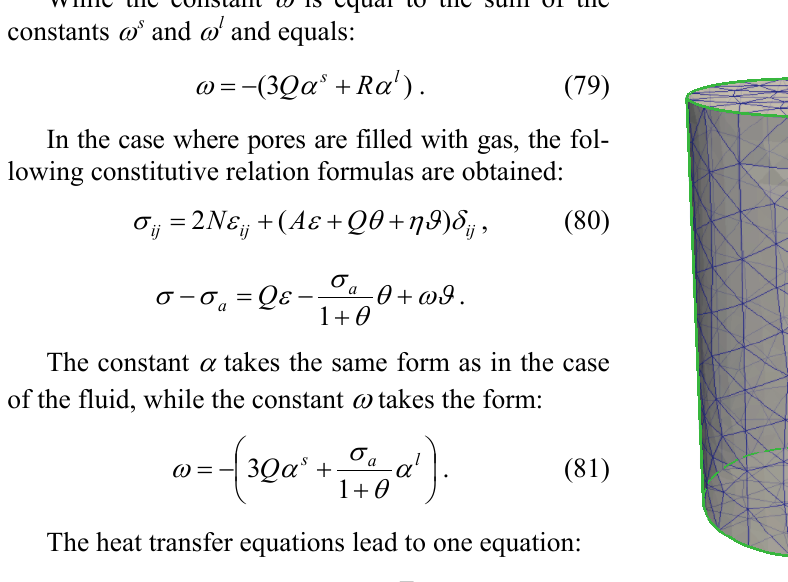
Fig. 1. The outer structure of the element and boundary